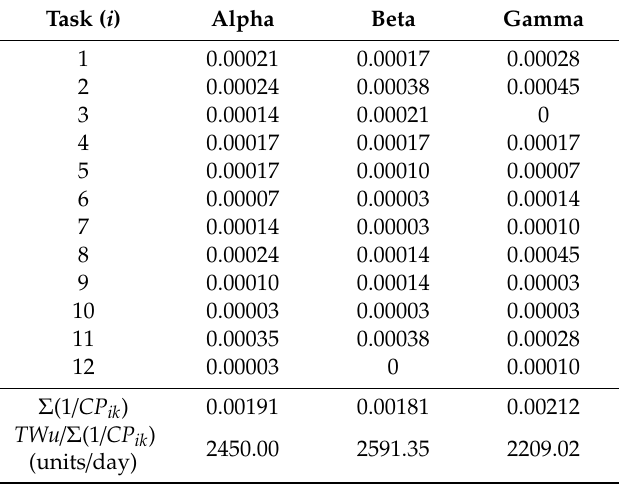
Table 6. Reciprocal values of the required capacity per task and model 1 / CP ik